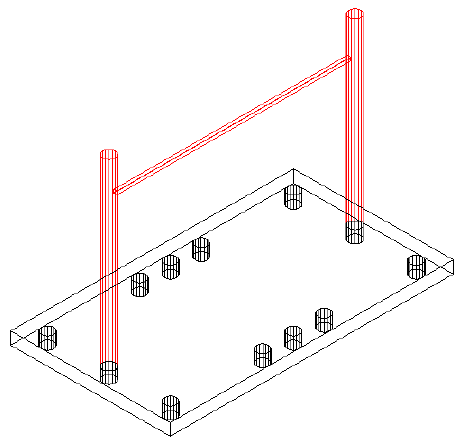
Figure 7. Platform for 3D